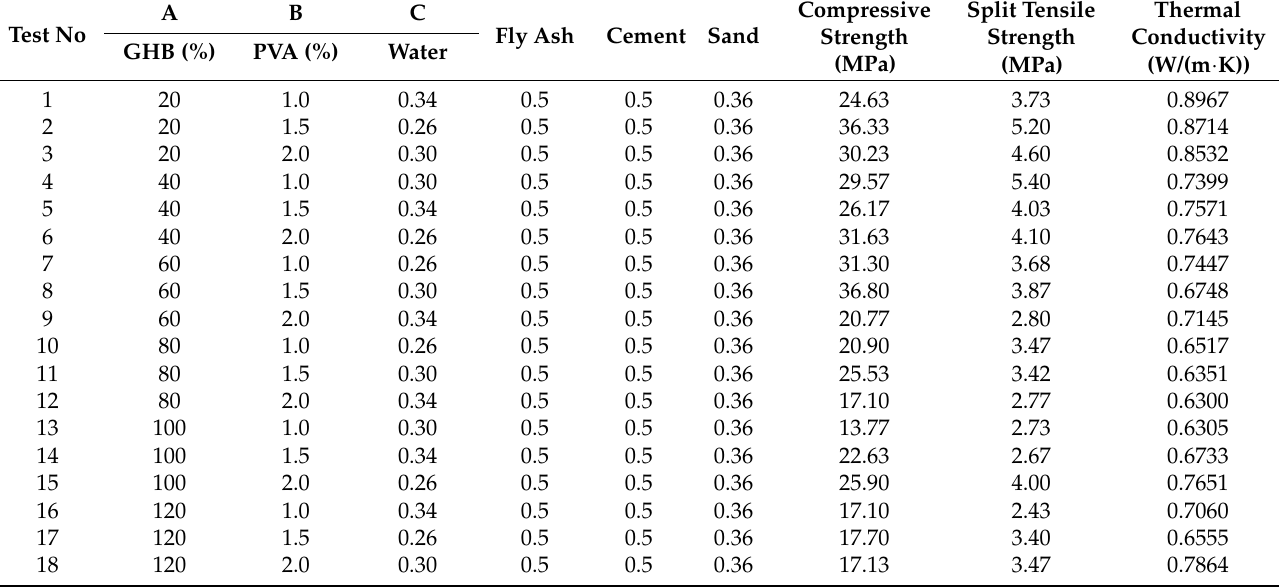
Table 4. Mix proportions and test